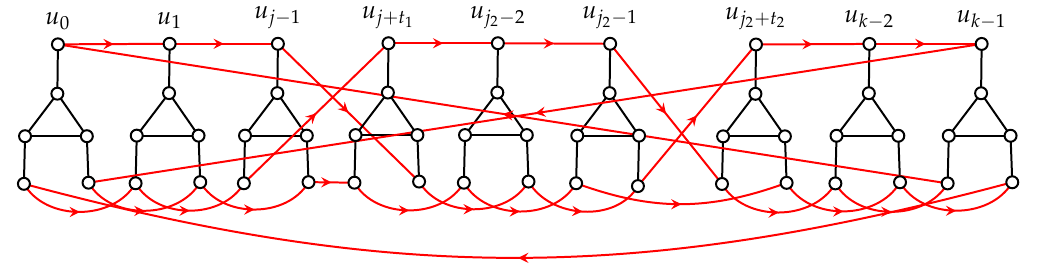
Figure 7. A cycle containning all vertices of U in P (cid:48)(cid:48)